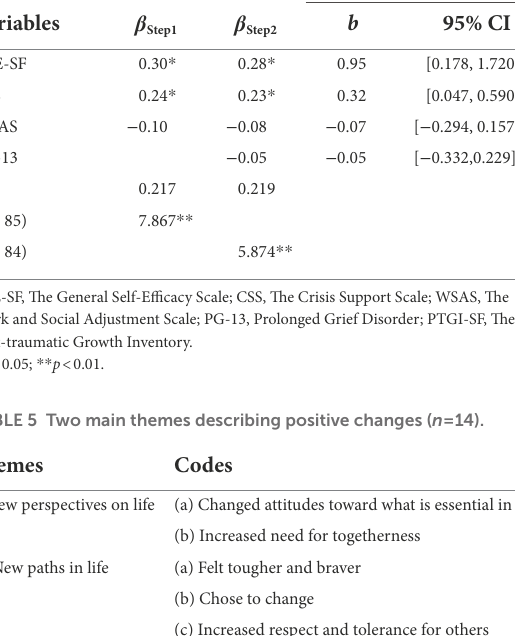
TABLE 4 Summary of multiple regression analysis predicting: PTGI-SF ( n = 89).